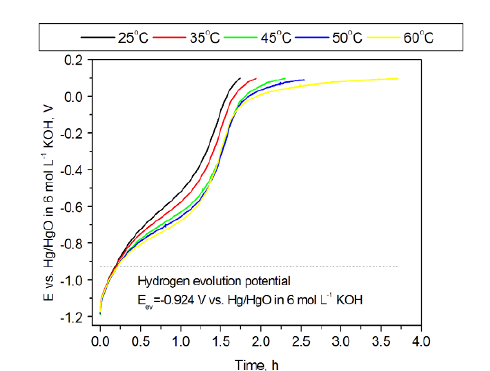
Figure 6. Hydrogen capacity (mAh/g) during cycling. Charging: I = - 5A g -1 pulse mode; Q = 500 mAh g -1 . Charging with pulse mode (1 s pulse, 0.5 s pause) compared to constant charging without pauses. Discharging